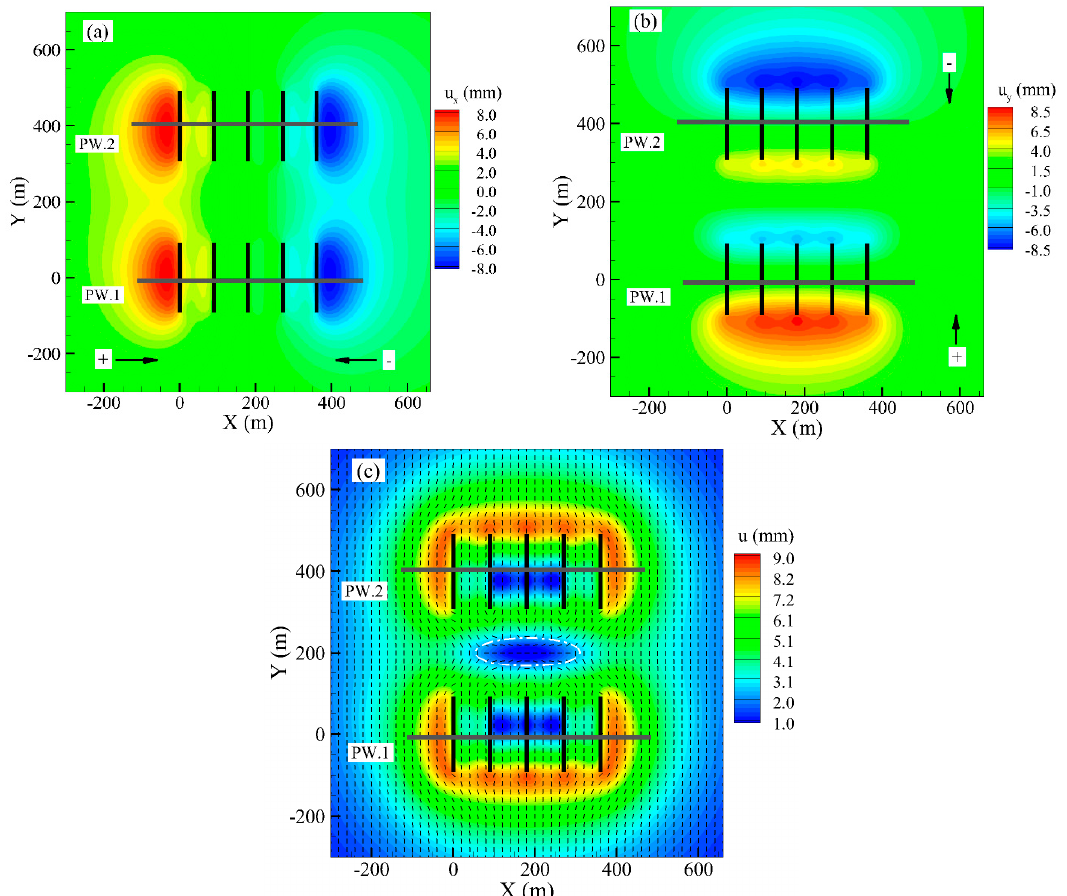
Figure 16. Depletion-induced reservoir displacements after 2 years of production: ( a ) displacement along the wellbore axis (i.e., along the x -axis), ( b ) displacement perpendicular to the wellbore axis (i.e., along the y -axis), and ( c ) resultant displacement distribution and dotted “black” lines show resultant displacement direction.